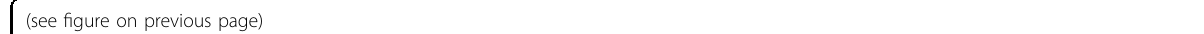
Fig. 1 Comparative unbiased proteomic analysis identi fi es downregulation of CXCL4/PF4 in HSC/MPPs of PV patients. A Gene set enrichment analysis (GSEA) comparing untreated PV patients against controls (PV.UT.HSC/MPP versus Control.HSC/MPP; PV.UT.CMP/MEP versus Control.CMP/MEP) and assessing for the effect of treatment with hydroxyurea (PV.HU.HSC/MPP versus PV.UT.HSC/MPP; PV.HU.CMP/MEP versus PV.UT.CMP/MEP). Shown are normalized enrichment scores (NES) for individual gene sets. Signi fi cantly upregulated gene sets are marked in red color, signi fi cantly downregulated gene sets are marked in blue color. Only RNAs and proteins expressed in at least half of the replicates in both comparison groups were considered. UT untreated, HU patient under treatment with hydroxyurea. B Heatmap of proteins enriched in different patient and control groups for megakaryocyte differentiation and regulation. C Volcano plot of protein intensity fold changes and p-values comparing HSC/MPPs of untreated PV patients (PV.UT.HSC/MPP) against controls (Control.HSC/MPP). D Normalized protein intensities for CXCL4/ PF4 in the subgroups of controls, chronic PV patients without cytoreductive therapy (PVchron.UT), chronic PV patients with hydroxyurea therapy (PVchron.HU), and progressed PV patients (PVprog). Error bars represent standard deviations. *adj. P < 0.05; **adj. P < 0.01; ***adj. P < 0.001 Peptide pro fi les for CXCL4/PF4 are provided in Supplementary Fig. 1. E Graphical summary of intracellular FACS staining experiments for CXCL4/ PF4 in six untreated chronic PV patients and age- and gender-matched controls. Error bars represent standard deviations. F Normalized CXCL4/ PF4 expression values for protein and RNA in individual patient and control samples. Discrepant high RNA and low protein levels were seen in progressed PV patients with fi brosis (post-PV MF) but not in post-PV